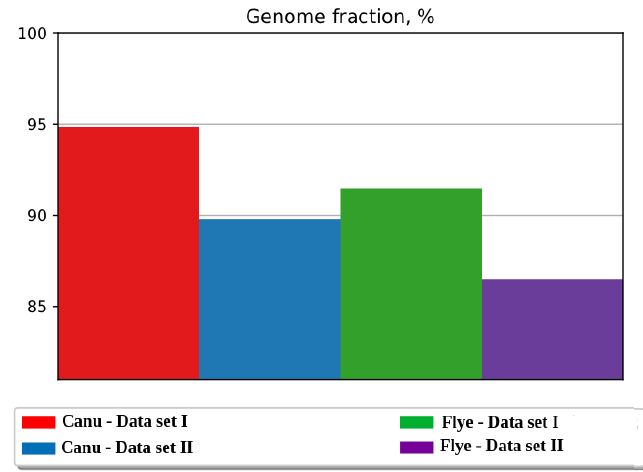
Table 3. QUAST-LG statistics for the de novo assemblies obtained with Canu and Flye using Data set I and Data set II.